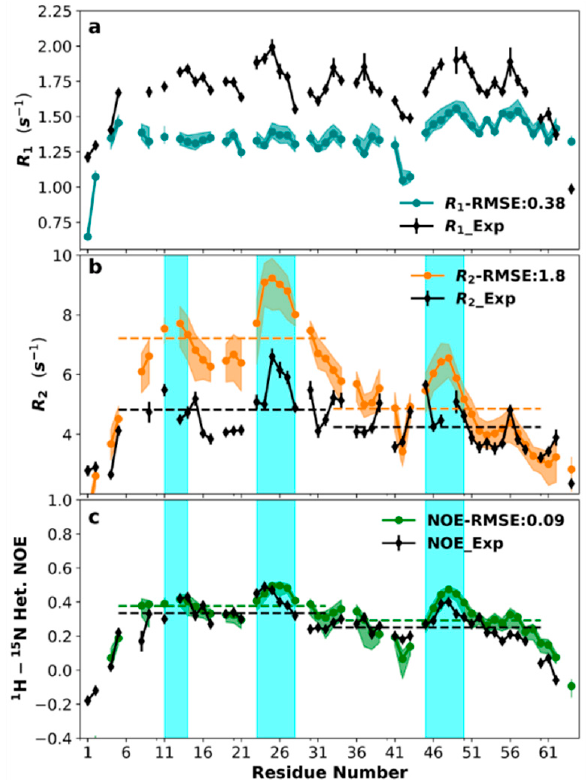
Figure 6. Backbone 15 N relaxation properties. ( a ) R 1 , ( b ) R 2 , and ( c ) nuclear Overhauser enhancements (NOE). Experimental data (pH 7.0) are in black; MD results are in blue, orange, and green, with shaded bands indicating 95% confidence intervals. Dashed lines indicate averages over residues 5–32 and 33–60; shaded cyan regions highlight residues (11–14, 23–28, and 46–50) with higher-than-average R 2 s and NOEs. Gaps in the plots are due to prolines (and unresolved residues in the case of experimental data).